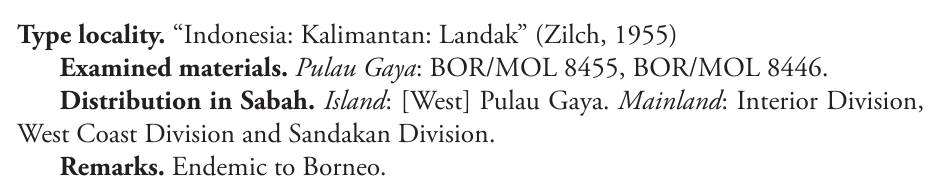
Ditropopsis koperbergi (Zilch, 1955) Figure 4B Type locality. “Indonesia: Kalimantan: Landak” (Zilch, 1955) Examined materials. Pulau Gaya : BOR/MOL 8455, BOR/MOL 8446. Distribution in Sabah. Island : [West] Pulau Gaya. Mainland : Interior Division, West Coast Division and Sandakan Division. Remarks. Endemic to